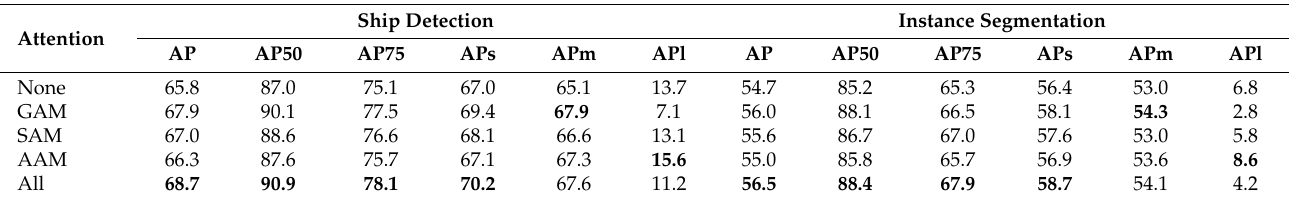
Table 3. Ablation experiment of each attention module proposed in this paper.